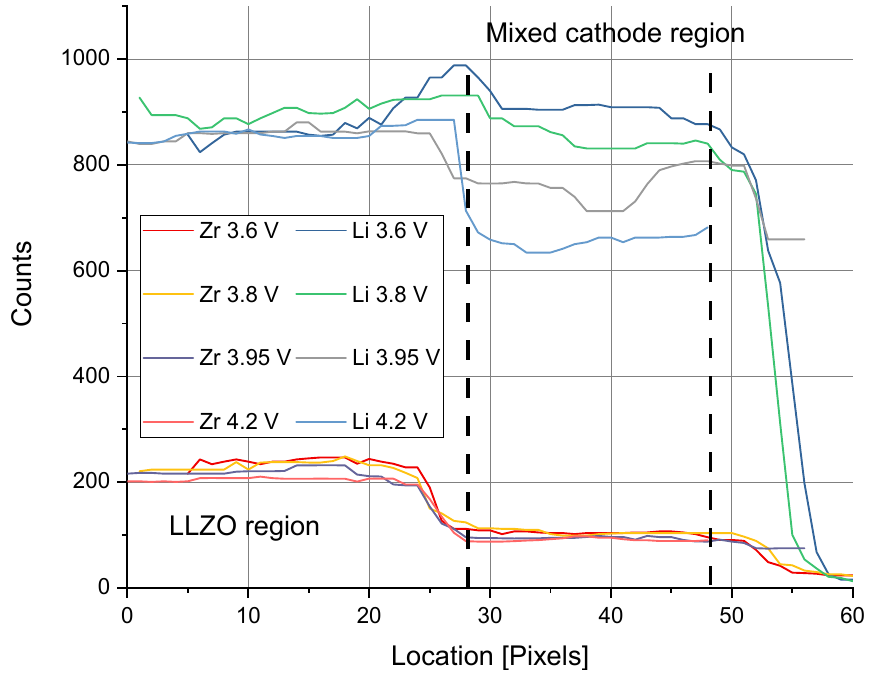
Figure 2. 1D plot of the signal intensity for Zr (PIXE) and Li (PIGE) for all four LLZO-based cells. Pure LLZO separator on the left, LCO + LLZO mixed cathode on the right side. Dotted lines mark the ~100- µ m-thick LLZO + LCO cell regions over which the counts were integrated to obtain the absolute Li